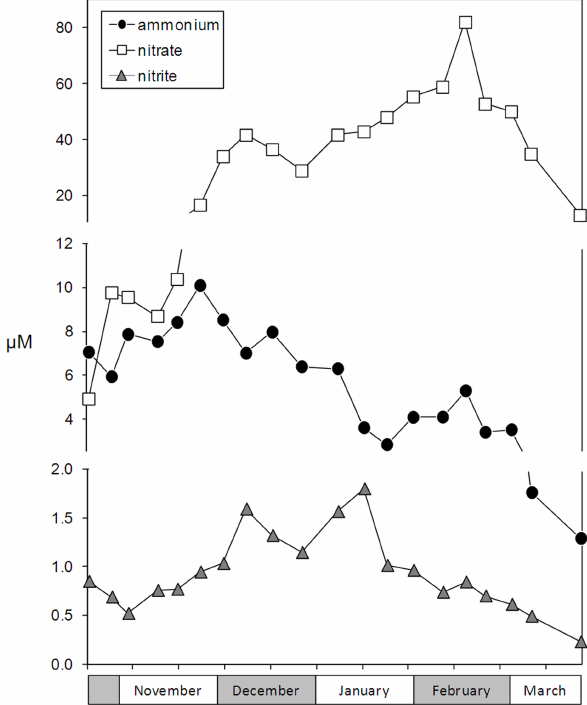
Fig. 1. Concentrations of ammonium, nitrate and nitrite during the winter of 2007–2008 in the Marsdiep channel. Note breaks in